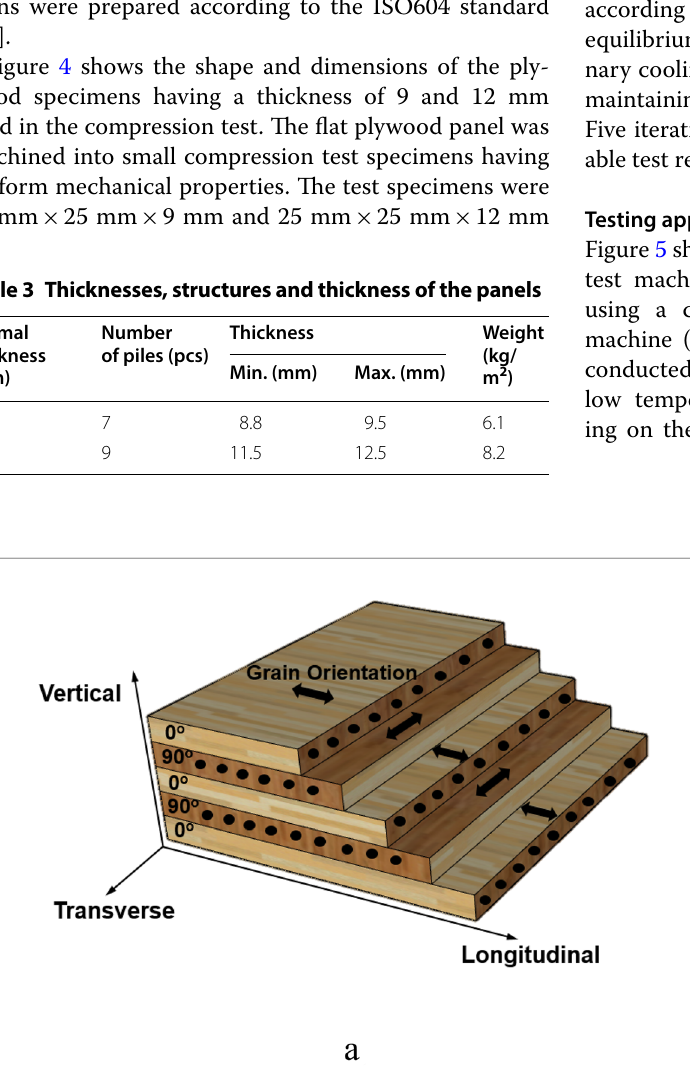
Fig. 3 a Photograph of the plywood compression specimen and b schematic diagram of the plywood panels with differing grain